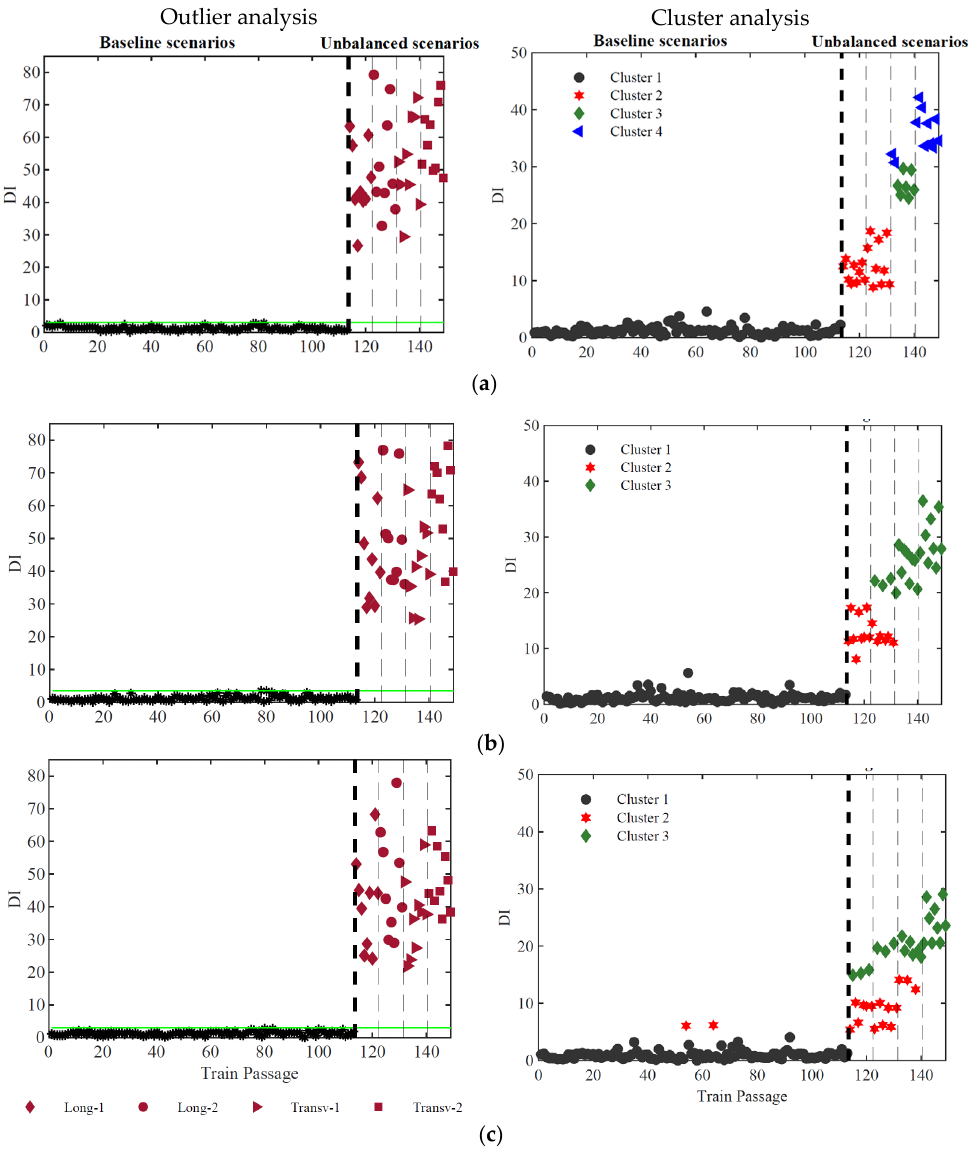
Figure 17. Sensitivity analysis with respect to the number of sensors (accelerometers + strain gauges): ( a ) 16 sensors (8 + 8); ( b ) 8 sensors (4 + 4); ( c ) 4 sensors (2 + 2).